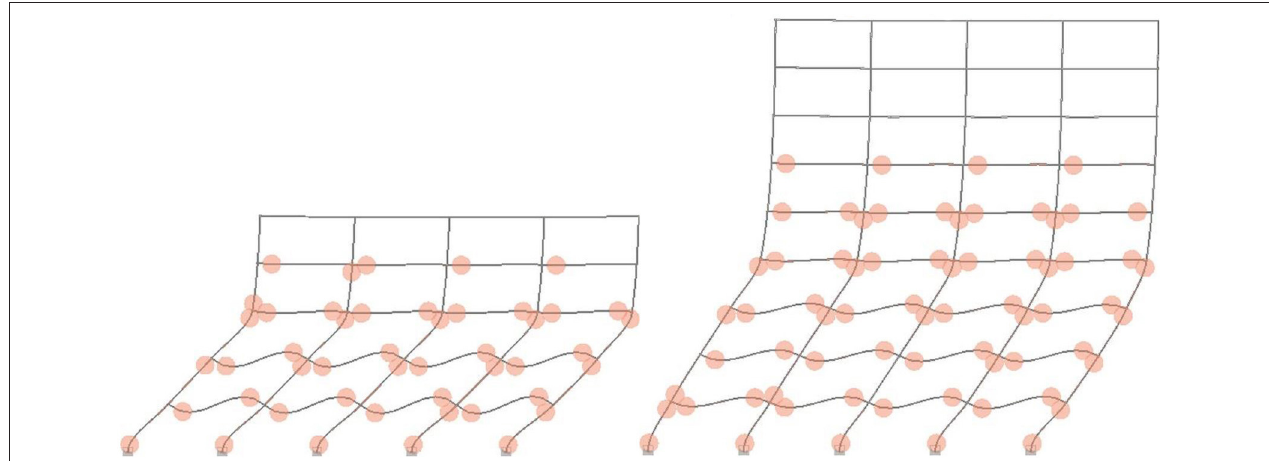
FIGURE 4 | Deformed shaped and plastic hinge formation for the five-story model (Left) and for the nine-story model (Right) for the considered collapse limit state (50% drop in the pushover curve).